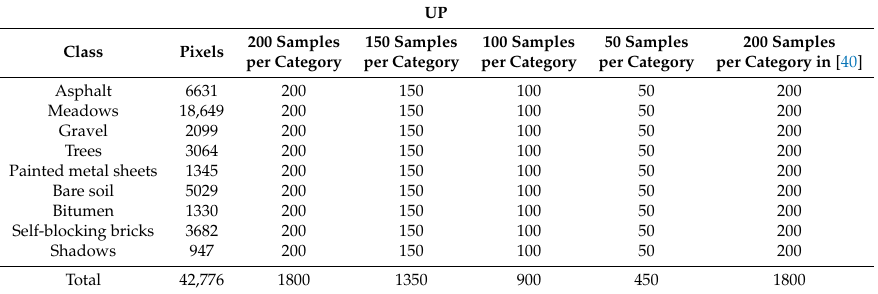
Table 9. Number of training samples used by the spatial-spectral FFPNet for the UP dataset.